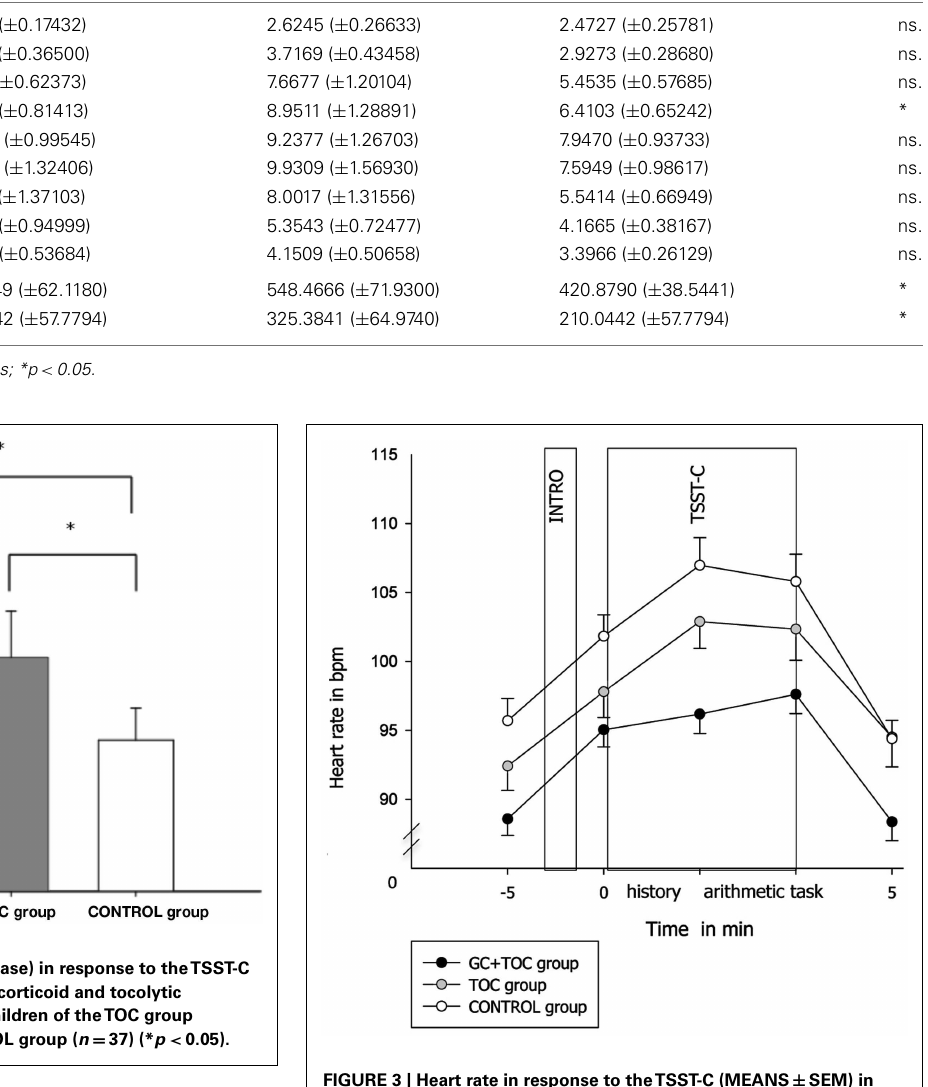
FIGURE 3 | Heart rate in response to theTSST-C (MEANS ± SEM) in children with glucocorticoid and tocolytic (GC + TOC) administration ( n = 43), in children of theTOC group ( n = 35), and in children of the CONTROL group ( n =